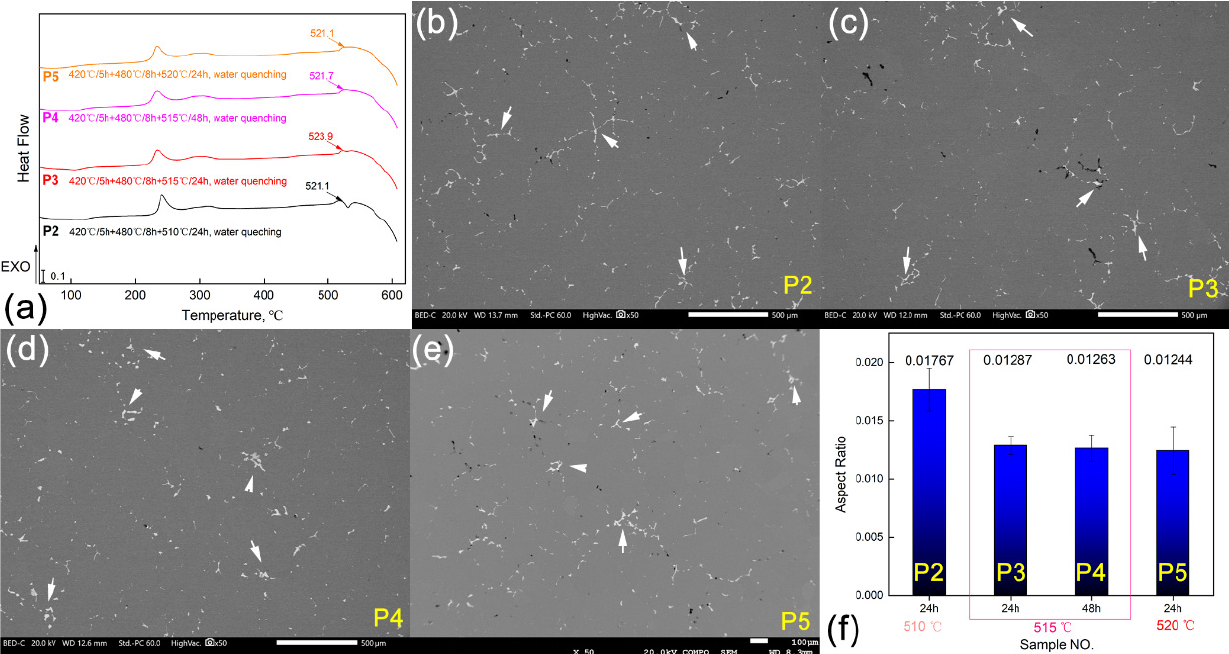
Figure 5. DSC analysis results of the Al-Cu-Mg-Ag alloy homogenized by P2, P3, P4, and P5 ( a ), SEM-BSE images and the EDS point analysis results of the homogenized Al-Cu-Mg-Ag alloy corresponding to the homogenization principles of P2, P3, P4, and P5 ( b ), ( c ), ( d ), ( e ), and ( f ), respectively.